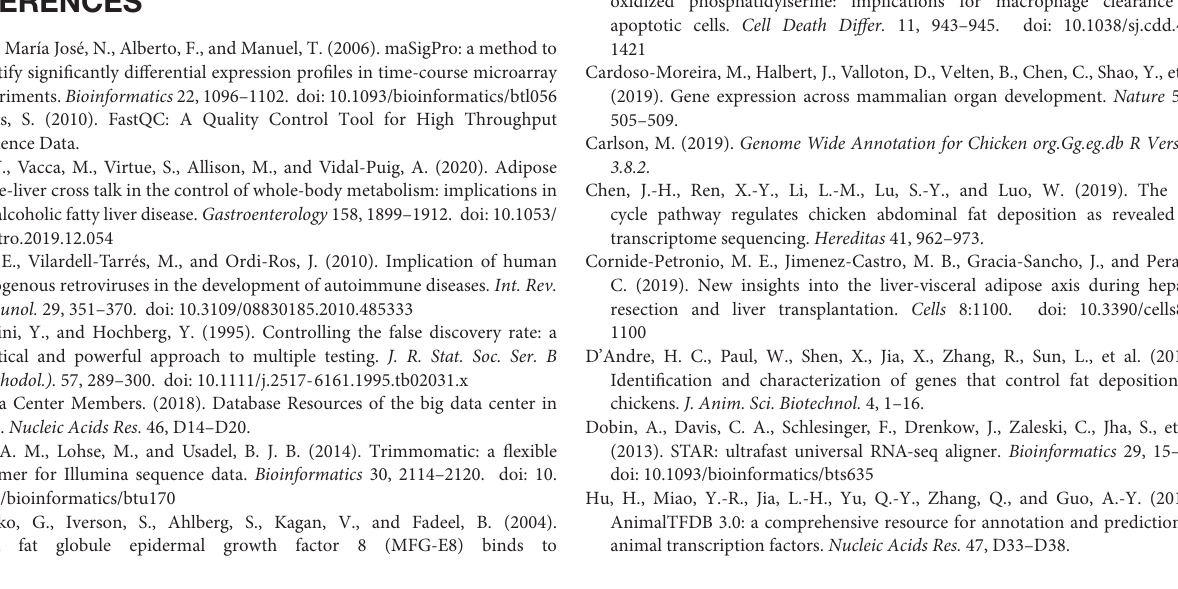
Supplementary Figure 1 | Liver stage-specific expressed genes enriched pathways. Supplementary Figure 2 | Liver switched-on genes enriched pathways. Supplementary Figure 3 | Liver switched-off genes enriched pathways. Supplementary Figure 4 | WGCNA processing figures. (A) Outliers. (B) Optimal soft-threshold selection. (C) Cluster dendrogram. Supplementary Figure 5 | Module networks. Yellow nodes stand for hub genes. Supplementary Figure 6 | ACSBG2 impulse expressed in D98 stage. Supplementary Table 1 | Phenotypes of RNA-sequenced chickens. Supplementary Table 2 | Alignment ratio for each sequenced library. Supplementary Table 3 | Normalized gene expression matrix of each library. Supplementary Table 4 | The ubiquitously expressed gene list. Supplementary Table 5 | The stage-specific expressed gene list from E12 to D180. Supplementary Table 6 | The switch-on gene list from E17 to D180. Supplementary Table 7 | The switch-off gene list from E17 to D180. Supplementary Table 8 | The number of DEGs between each developmental stage. Supplementary Table 9 | The list of identified developmental dynamics genes (DDGs) and involved transcription